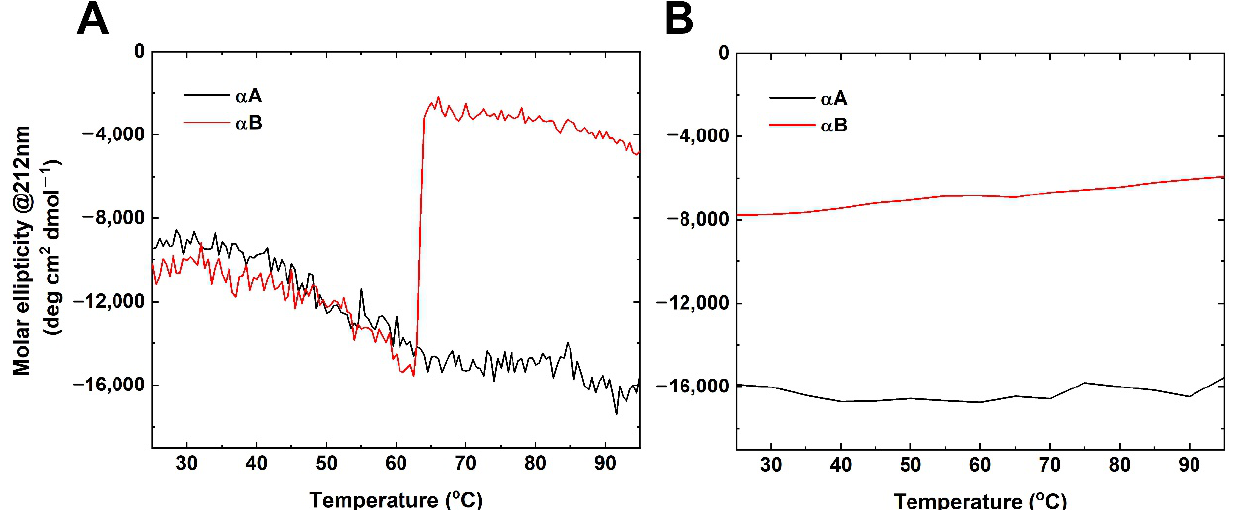
Figure 2. Representative ( A ) thermostability and ( B ) temperature reverse for αA and αB crystallin measured by circular dichroism. Circular dichroism signals at 212 nm were monitored at the rate of 1 °C/min from 25 to 95 °C and −5 °C/min from 95 to 25 °C, respectively.